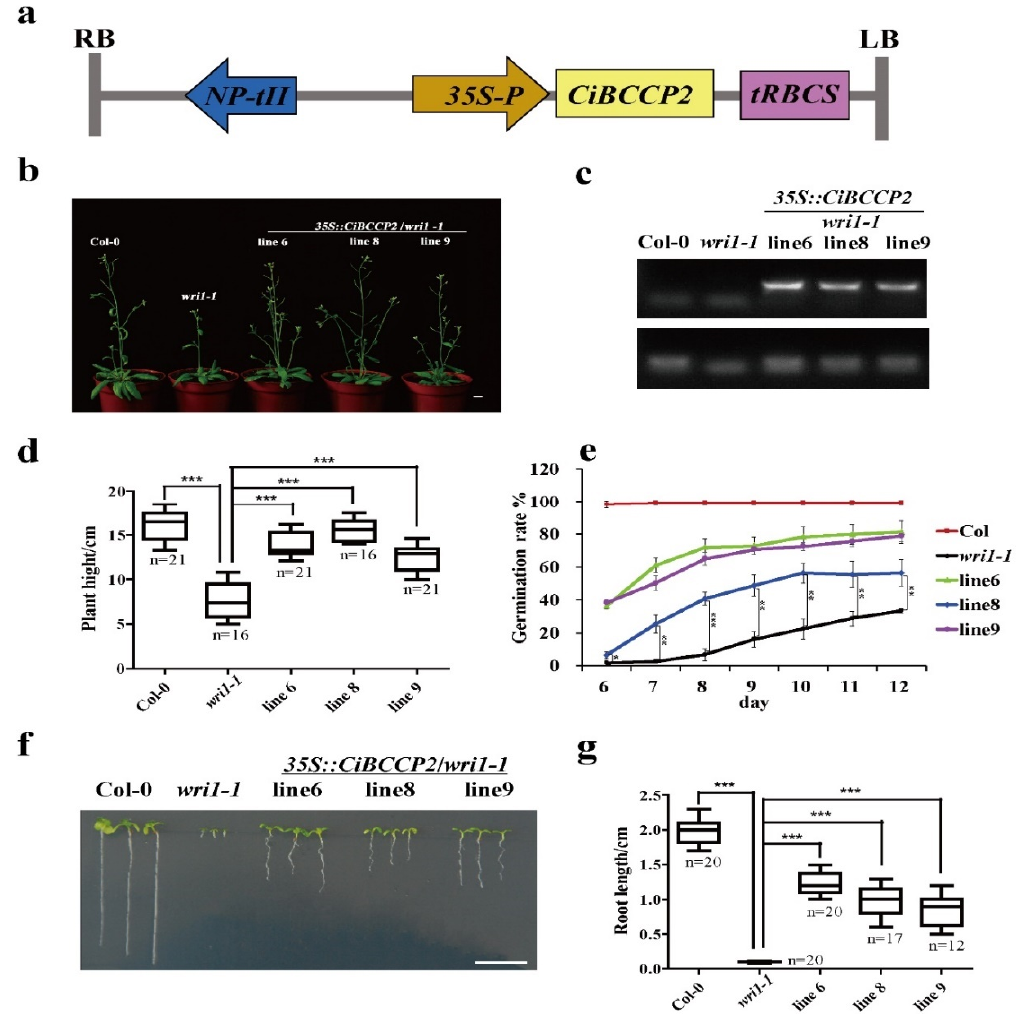
Figure 8. CiBCCP2 rescues developmental defects in the wri1-1 mutant. ( a ) Schematic of vector construction for CiBCCP2 overexpression in the wri1-1 mutant of Arabidopsis . ( b ) Plant height in 33-day-old wild-type, wri1-1 mutant, and three independent p35 S: CiBCCP2 / wri1-1 transgenic plants. ( c ) CiBCCP2 expression in three independent p35 S: CiBCCP2/wri1-1 transgenic plants in the T1 generation detected by semiquantitative RT-PCR. ( d ) Quantification of plant heights in ( b ). ( e ) Germination rates in wild-type ( n = 5 for each time point, 100 seeds for each biological replicate), wri1-1 mutant (n = 3 for each time point, 100 seeds for each biological replicate), and three independent p35 S: CiBCCP2/wri1-1 transgenic plants (Line 6, n = 4 for each time point; Line 8, n = 3 for each time point; Line 9, n = 4 for each time point; 100 seeds for each biological replicate). ( f ) Root length in 12-day-old wild-type, wri1-1 mutant, and three independent p35 S: CiBCCP2/wri1-1 transgenic plants. ( g ) Quantification of root lengths in (f). * p < 0.05, ** p < 0.01, *** p < 0.001 (Student’s t test). Bars =1 cm ( b , f ).